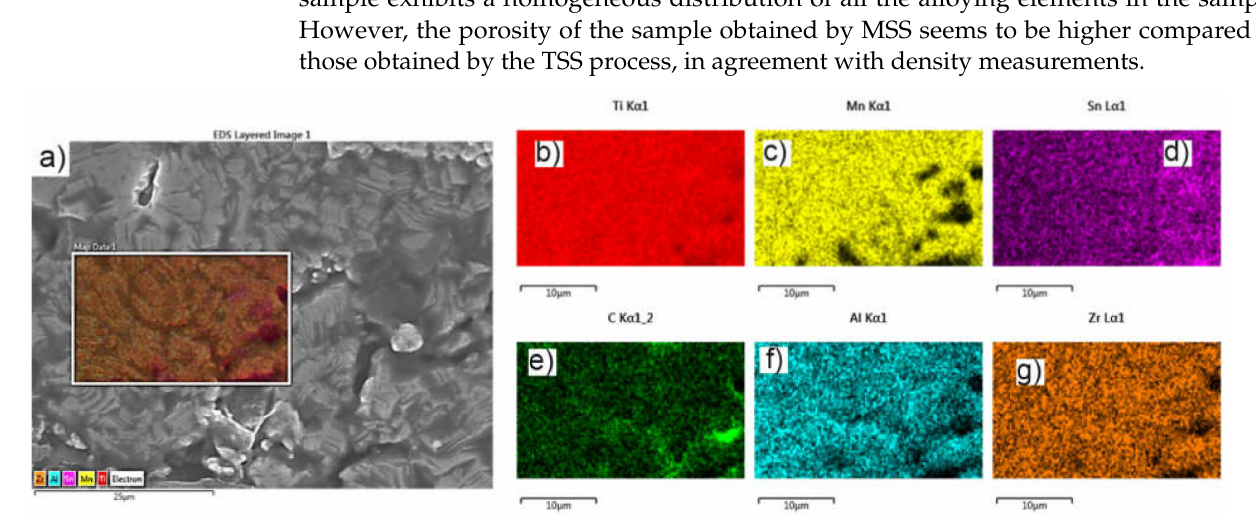
Figure 9. SEM image and EDXS elemental mapping for the sample obtained by MSS: ( a ) SEM image and overlayed maps, ( b ) Ti, ( c ) Mn, ( d ) Sn, ( e ) C, ( f ) Al and ( g ) Zr map